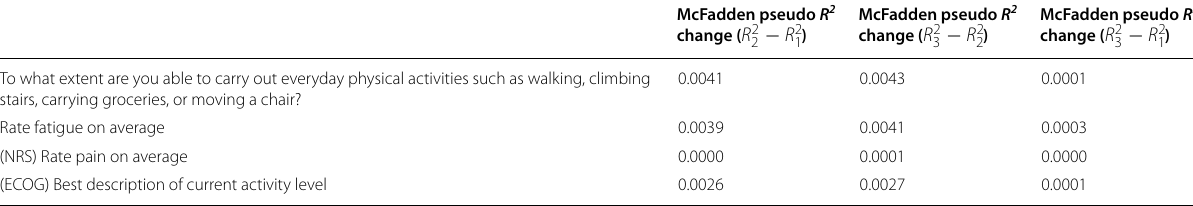
Table 7 Percentages of selecting the first or the last response option in single-item measures